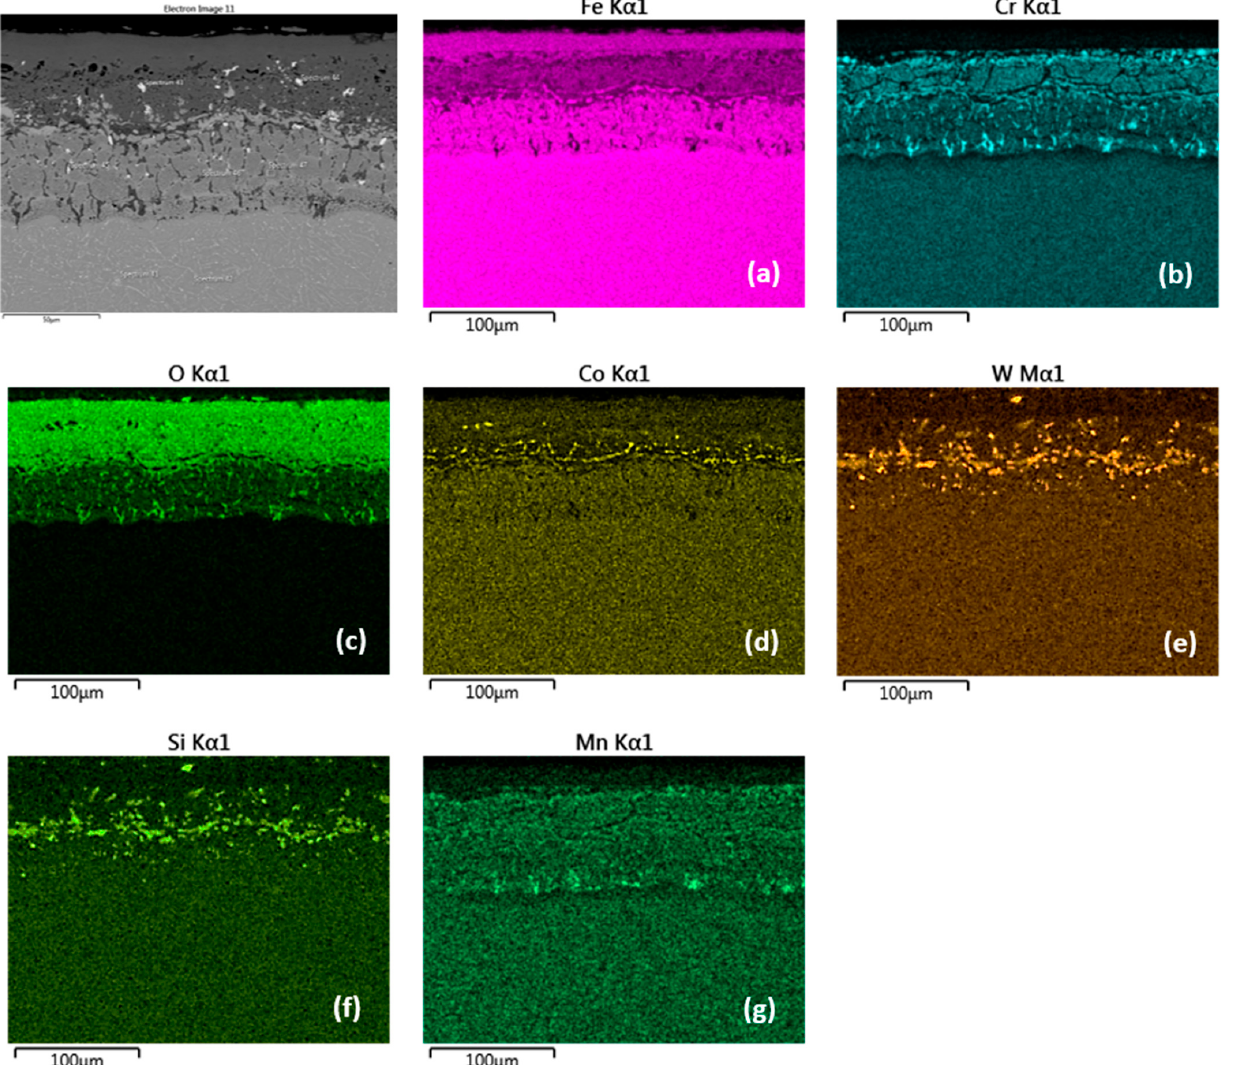
Figure 7. Cross-sectional SEM morphologies and EDS spectra analysis ( a – g ) of oxide films after oxidation for 2000 h, steel MarBN at 600 °C.